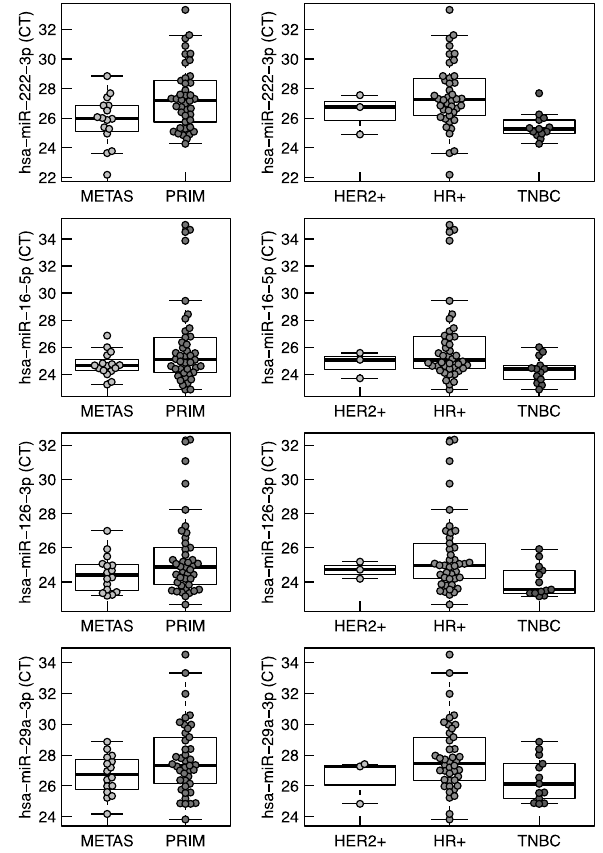
Figure 2. Boxplots of miRNA expression of selected housekeeper candidates per subgroup. METS: samples derived from metastasis; PRIM: samples derived from primary; HER2+: HER2 positive; HR+: hormone receptor positive; TNBC: triple negative breast cancer. Table 2. MicroRNA expressions of validation cohort.